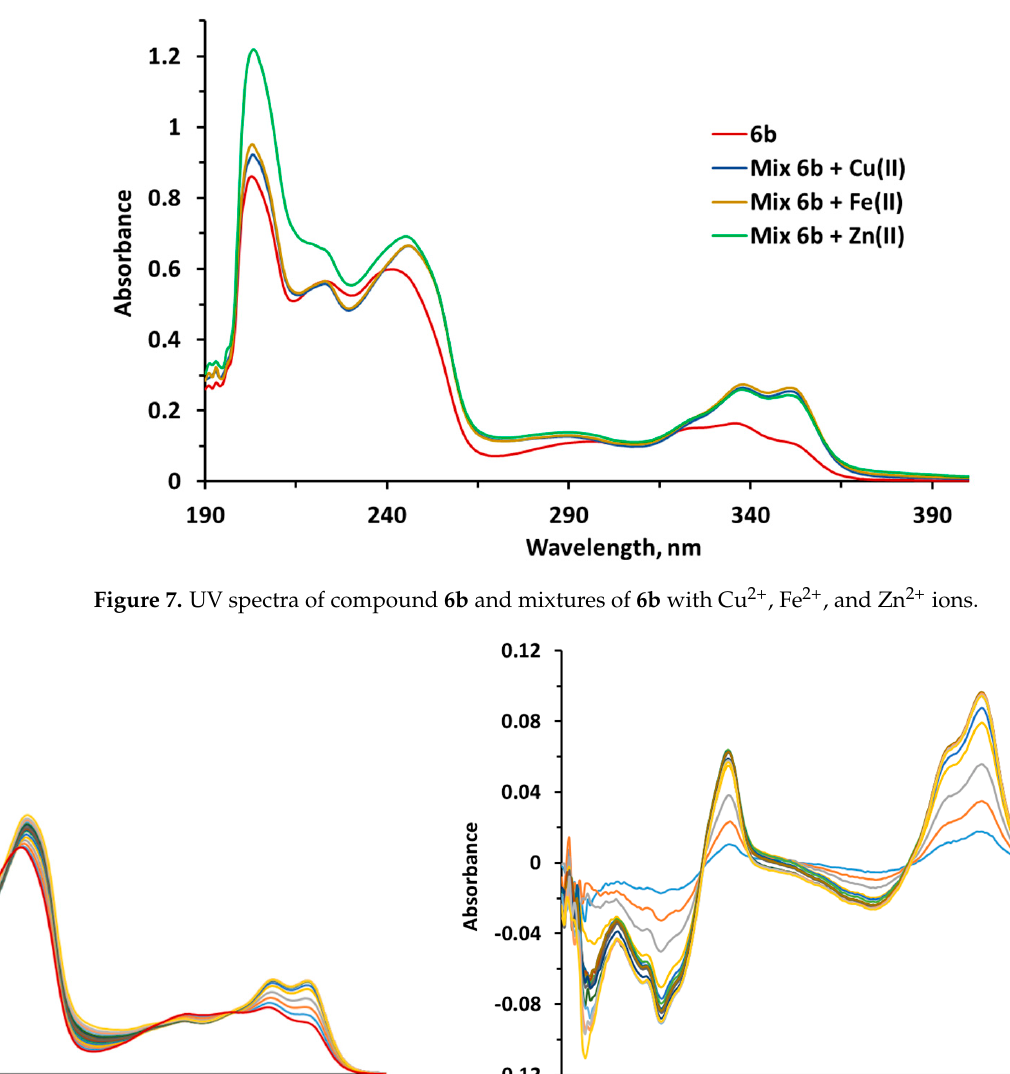
Table 5. Data on UV spectra of 5b , 6b , 7b , 8b , and 10b and their metal complexes.